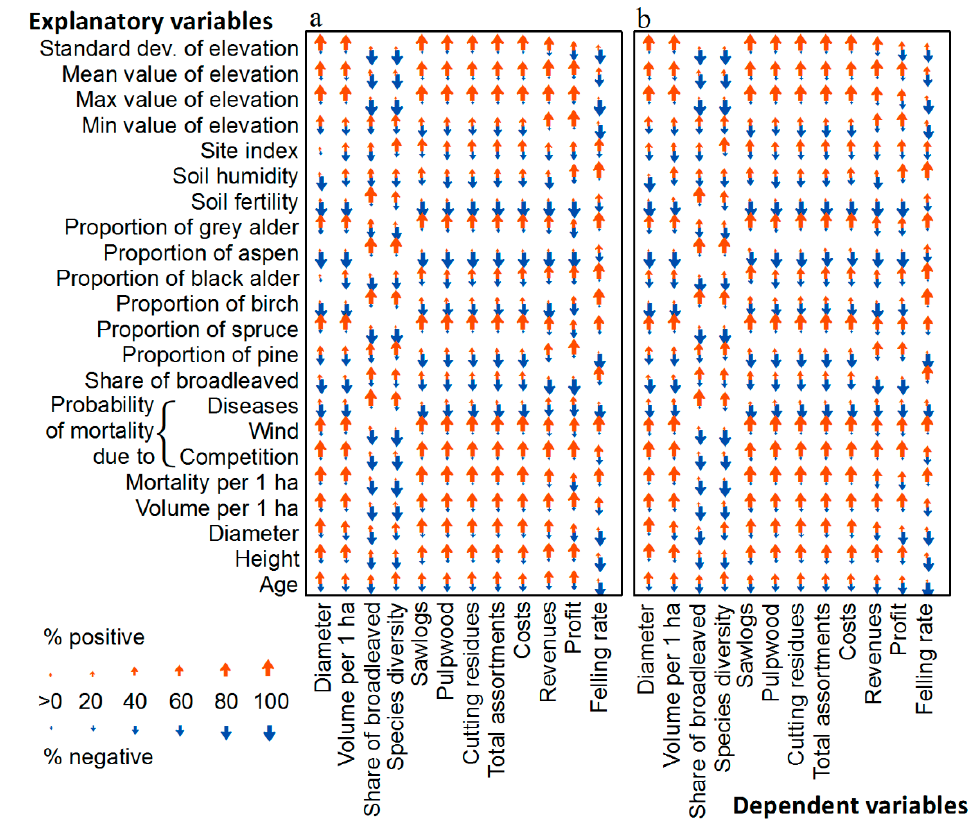
Figure 13. The stability of candidate explanatory variables in tested regression models: ( a ) REFERENCE scenario, ( b ) EU BIOENERGY scenario.